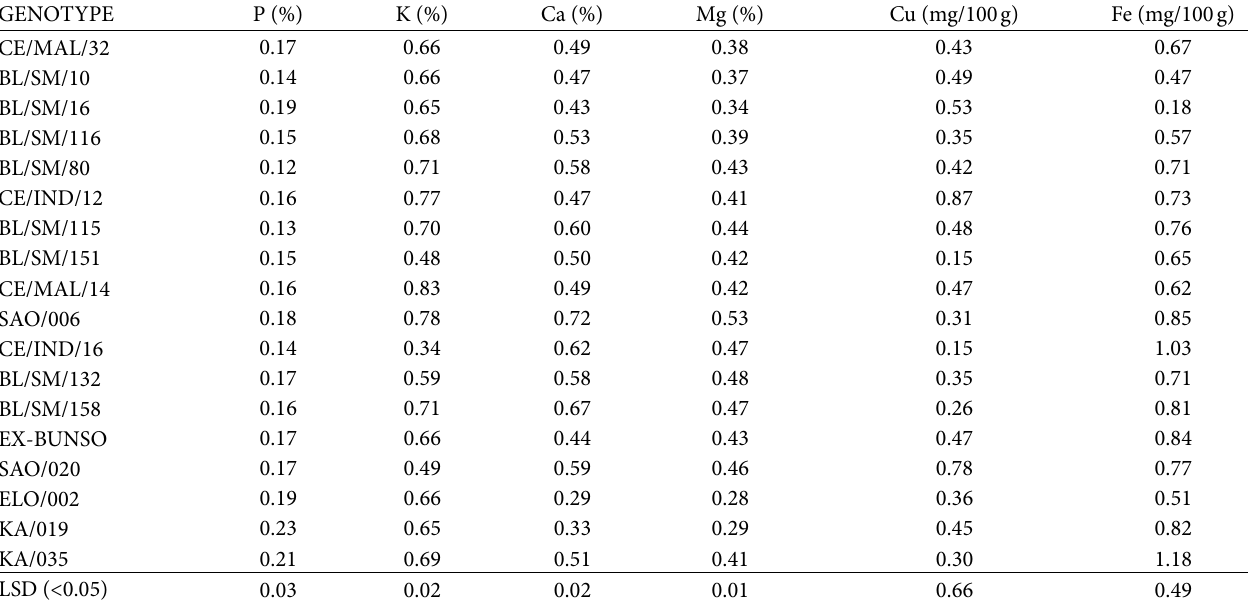
Table 3: Mineral composition of the 18 taro